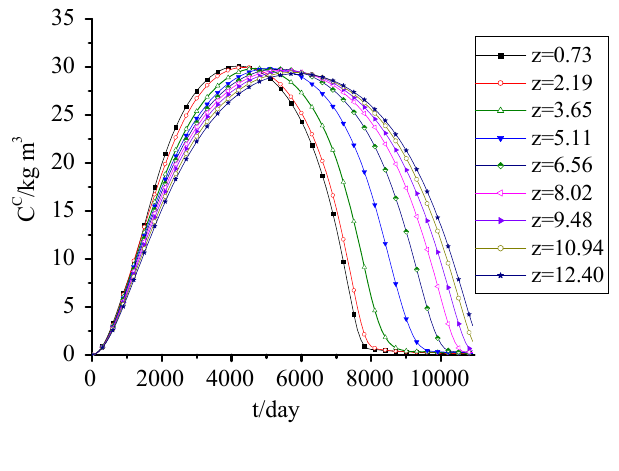
Figure 9. SDA concentration change with time.